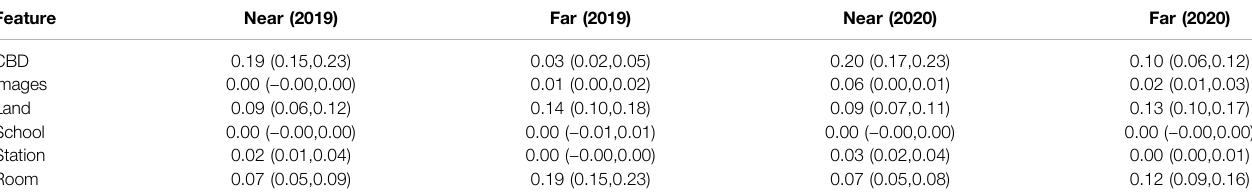
TABLE 3 | Shapley values and asymptotic CIs for the covariates of the real estate data. Feature